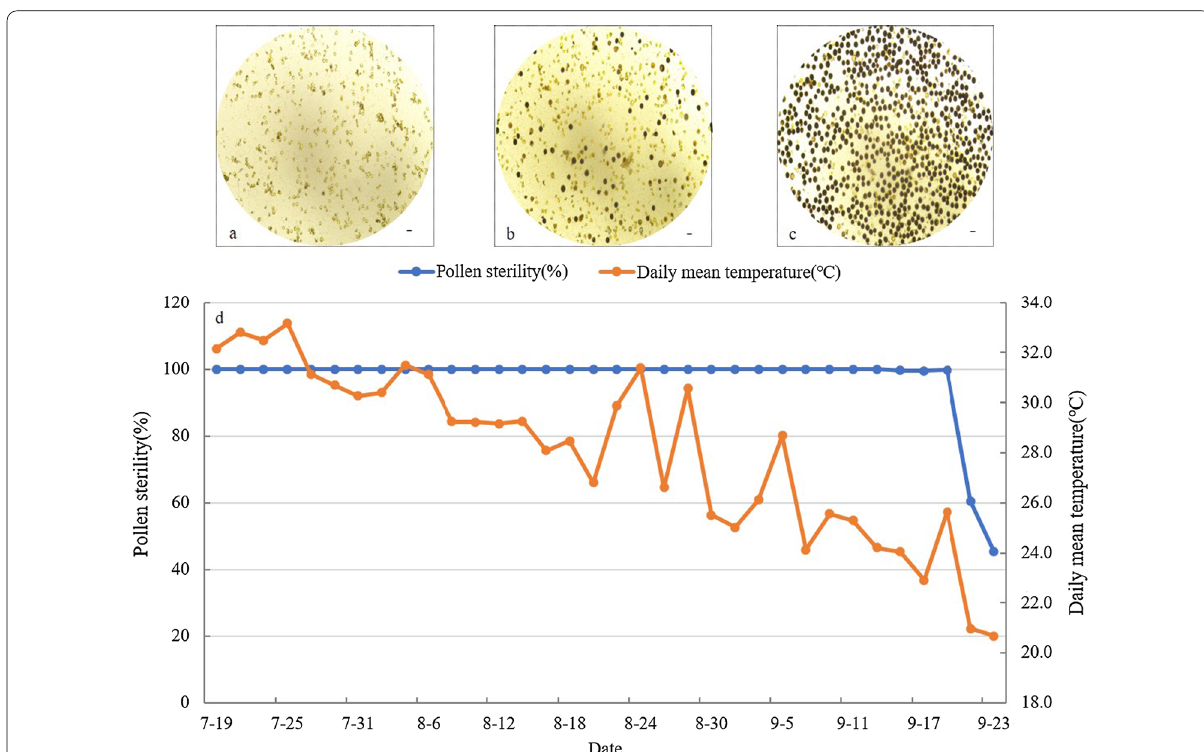
Fig.4 Fertility-sterility alteration pattern of Huhan 74S in 2017 at Shanghai. a – c Pollen grains from Huhan 74S on 12th August ( a ), 21st September ( b ) and 23th September ( c ). d Dynamic pollen sterility expressions of Huhan 74S relative to daily mean temperature (DMT) data between 19th July to 23th September in 2017 at Shanghai. Scale bars: 50